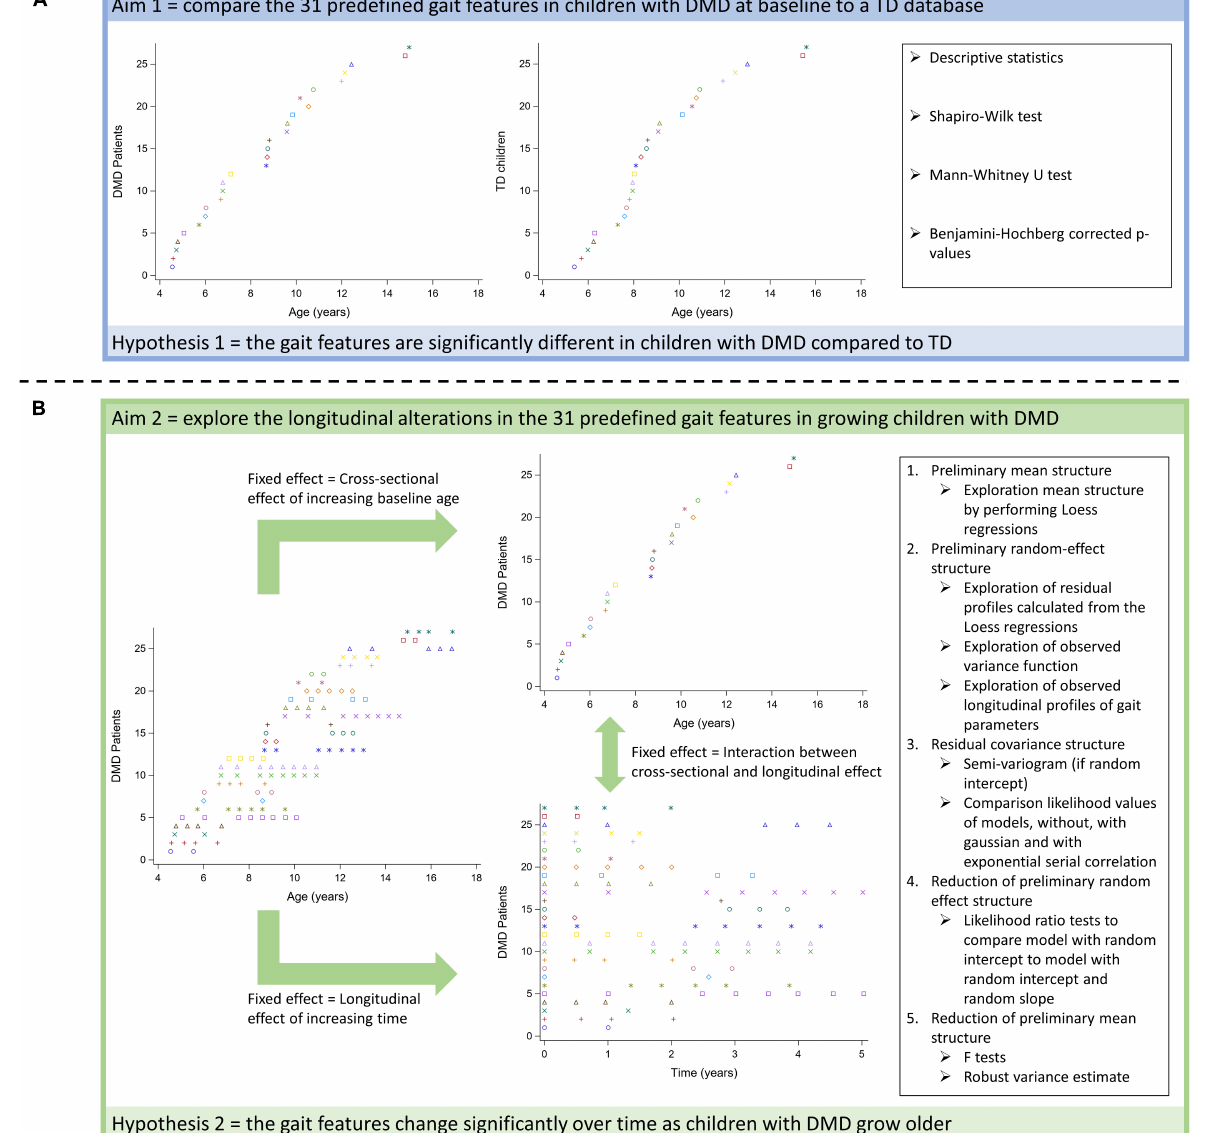
with WV norm , SL norm , SW norm , l , and g representing normalized leg length, and gravitational acceleration,